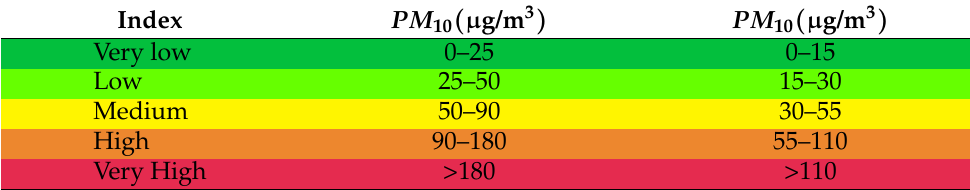
Table 1. European Common Air Quality